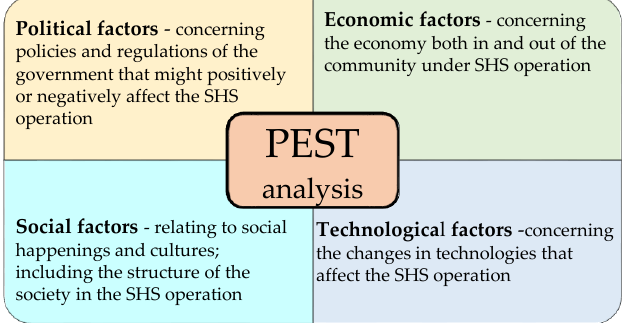
Figure 2. The paradigms of P-E-S-T (political, economic, social-cultural, and technology), based on the solar home system (SHS) project. Source: produced by the authors (2017).